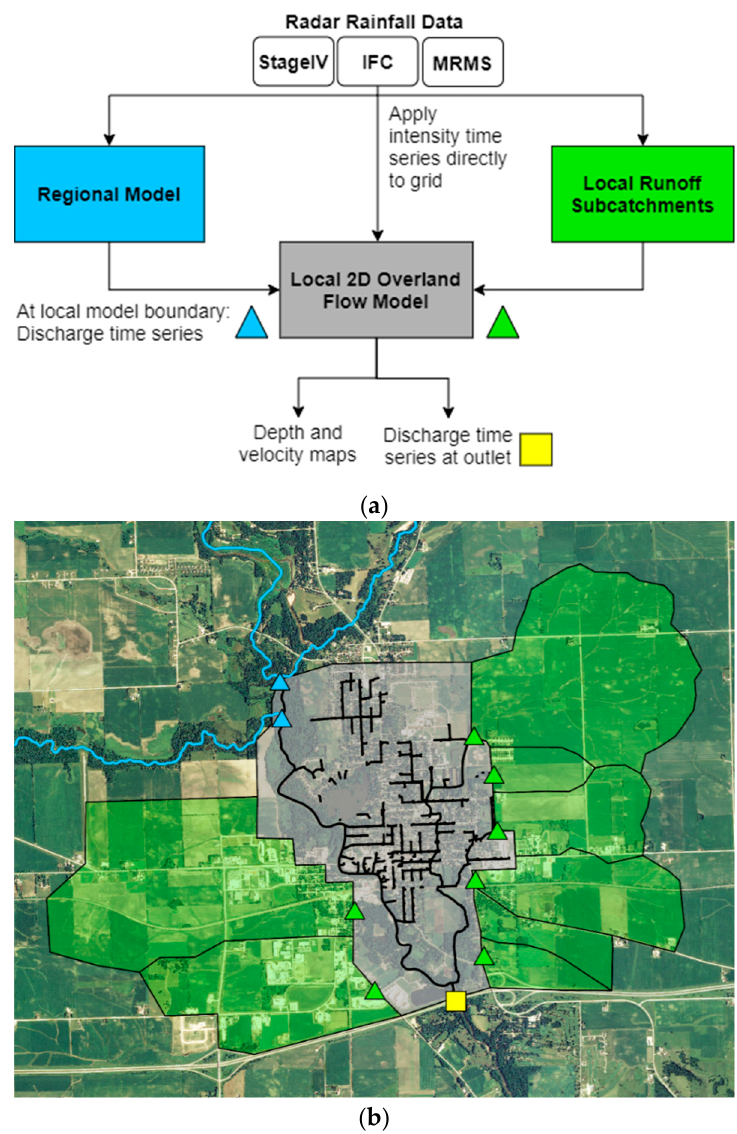
Figure 3. ( a ) The flow diagram of the nested regional–local model approach used to test the sensitivity of the streamflow predictions to various radar rainfall products and urban hydrodynamics. ( b ) The local XPSWMM model (XP—C2) included the green rainfall–runoff subcatchments, and their connections to the 2D domain (gray) are noted by green triangles. The blue triangles are the locations where the regional HLM streamflow is input into the XPSWMM model. The nested model and regional model outputs were compared to observations at the USGS streamflow gauge (yellow squares). The blue polylines (river network) were modeled by the HLM while the black polylines (river and urban drainage network) are modeled in XPSWMM.